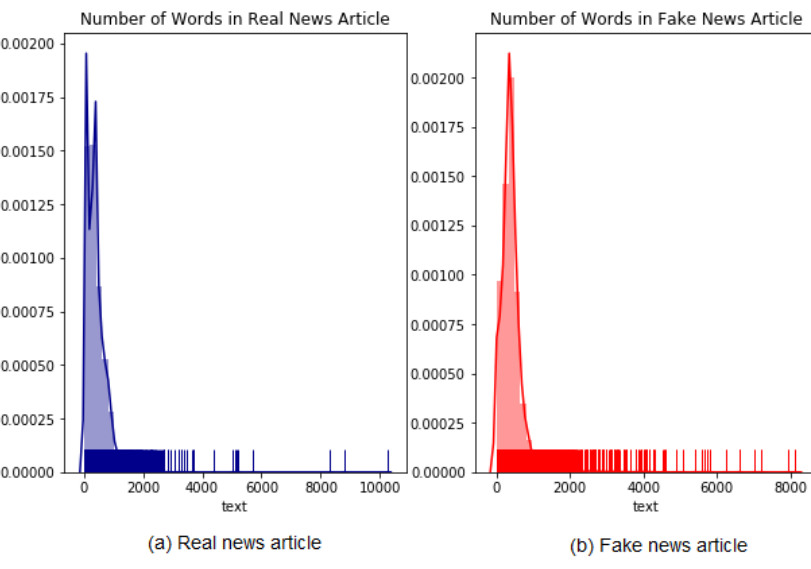
Figure 8. The average and standard deviation of body text.